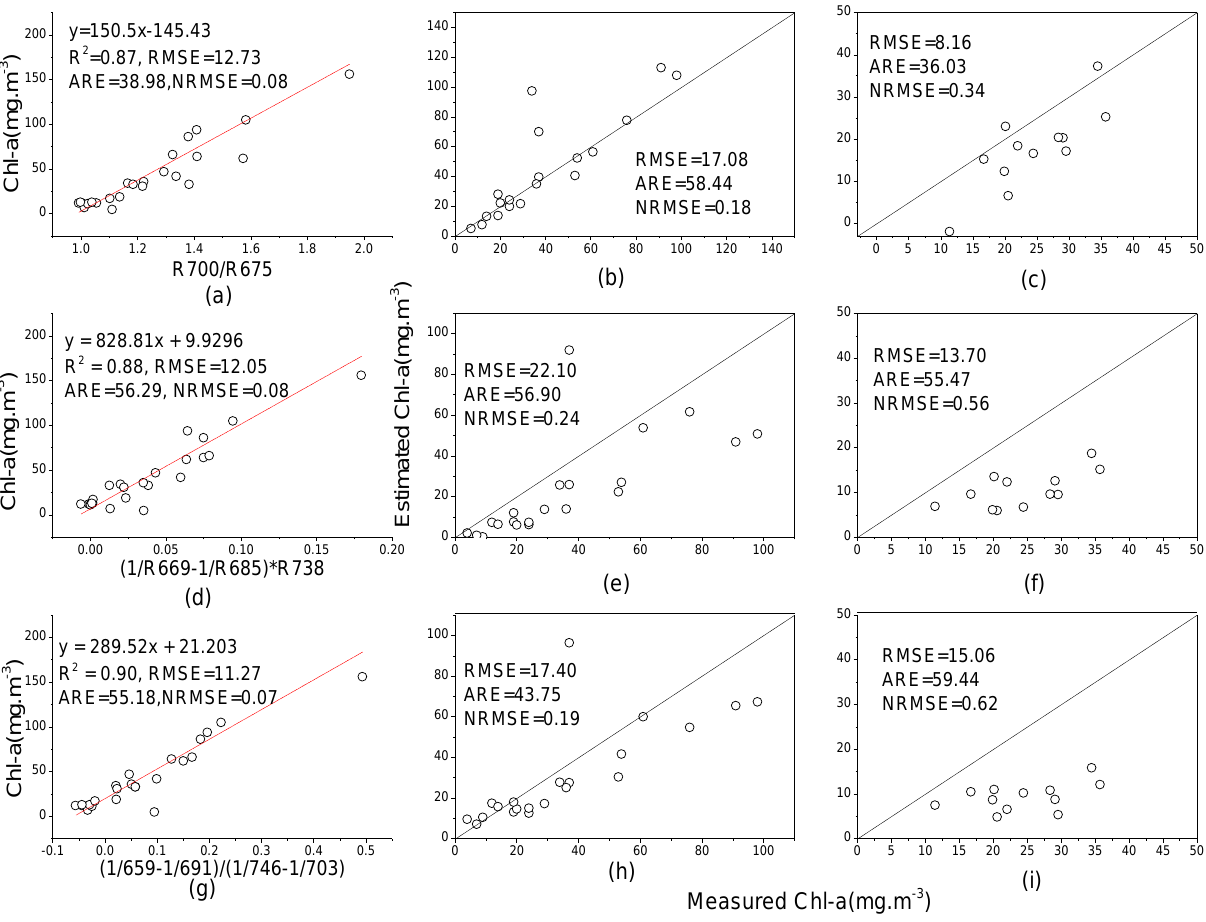
Figure 6. Three types of model built using the data from 2004 and their validation results using the data from 2005 and 2011. The band ratio model built using data from ( a ) 2004 and its validation using data from ( b ) 2005 and ( c ) 2011; three-band model built using data from ( d ) 2004 and its validation using data from ( e ) 2005 and ( f ) 2011; four-band model built using data from ( g ) 2004 and its validation using data from ( h ) 2005 and ( i )